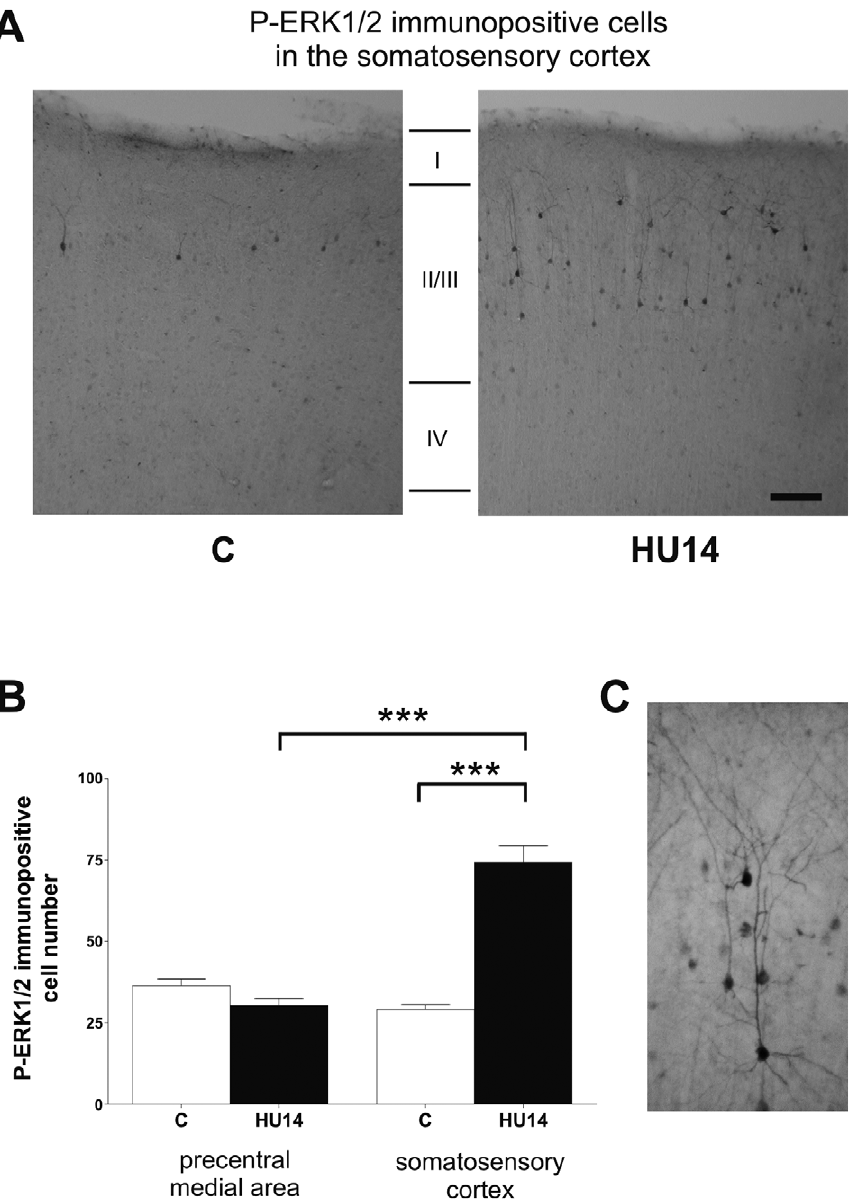
Figure 4. Hindlimb unloading increases ERK1/2 phosphorylation in layer II/III of the somatosensory cortex. (A) Representative photographs showing the spatial localization of P-ERK1/2 in the somatosensory cortex of C and HU14 rats. The coronal section was performed at stereotaxic coordinates A 2 1 from bregma. (B) Expression of the P-ERK1/2 immunopositive cell number in precentral medial area (used as reference) and the somatosensory cortex of C and HU14 rats. (C) High-magnification photograph of P-ERK1/2 immunopositive neurons showing staining in cell body and